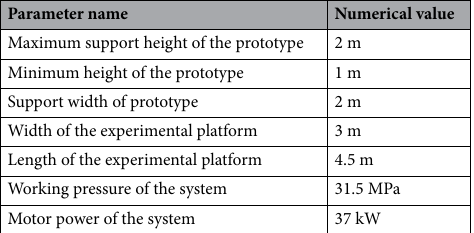
Table 18. Main technical parameters of the advanced hydraulic support experimental prototype.